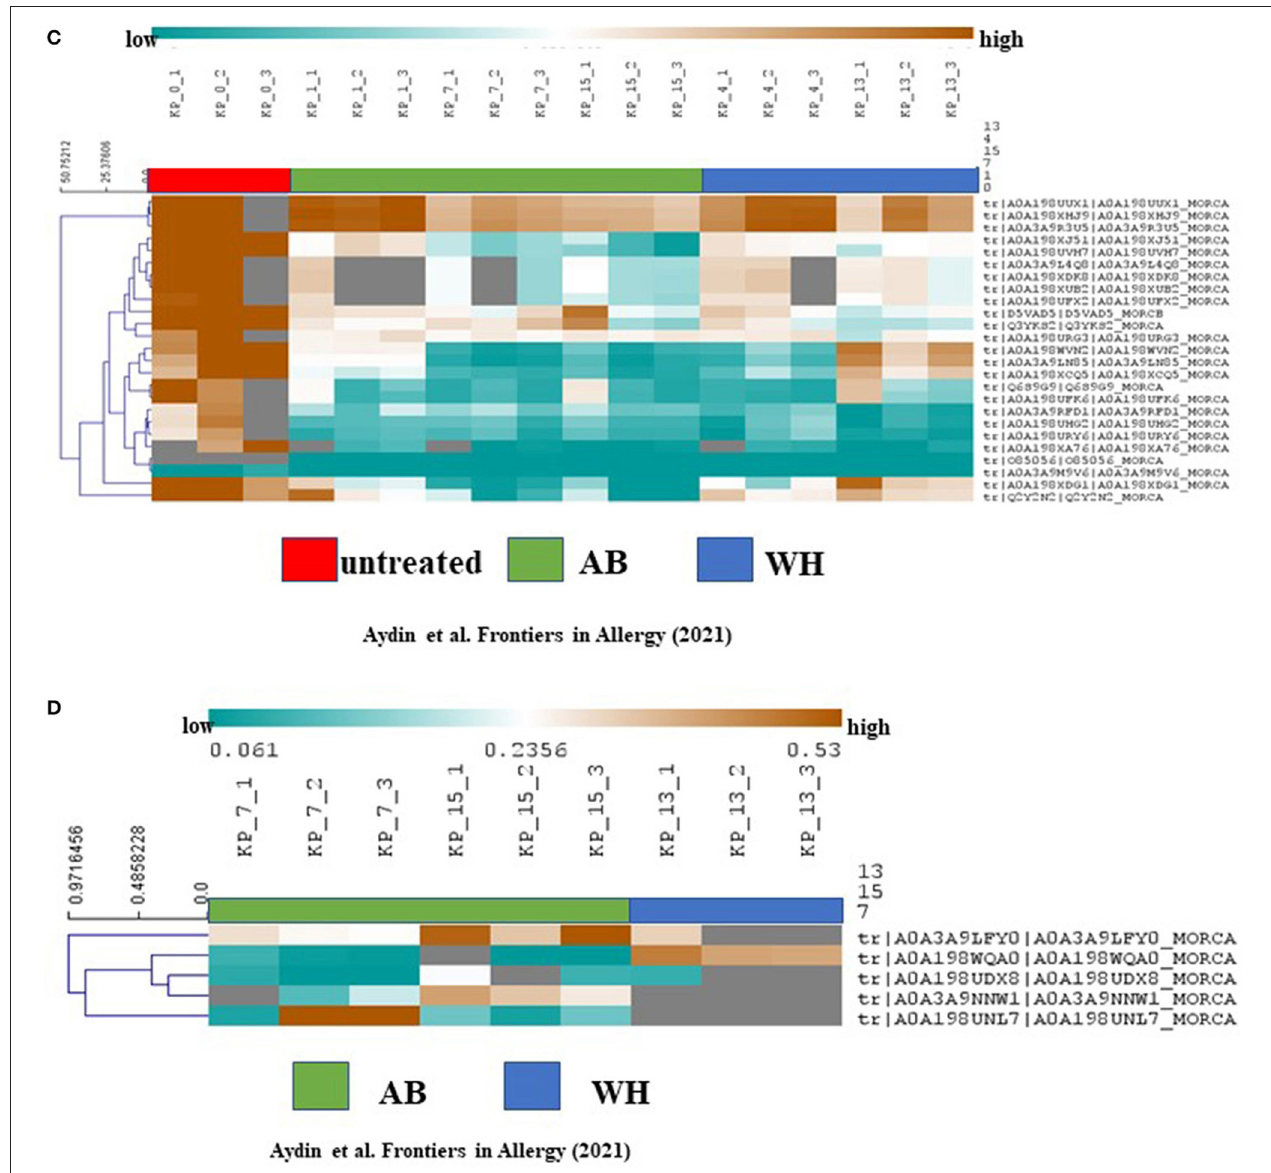
FIGURE 4 | Proteome analyses revealed cohort-specific differences and TtcA was associated with WH. (A) Proteome analyses of the cultures showed the following quantified proteins (left: human and M. catarrhalis ; right: M. catarrhalis ) highlighted in a Venn diagram, depicted in unteated (UT) (red), AB (green) and WH (blue). The size of the circular area is proportional to the number of quantified proteins in each group. Healthy controls had less protein differences compared to WH and AB. A distinct proportion in the AB group had cohort-specific proteome abundance levels. (B) Proteome analyses of the cultures including human and M. catarrhalis -associated proteins presented significant abundance levels in AB, WH, and UT groups. The abundance levels are colored ranging from blue (low abundance) to orange (high abundance). Gray color represents missing information for each protein in the group. Interestingly, AB, WH, and UT had common high abundance levels for ALBU_Human, K1C19_Human, A0A198UUX1_MORCA, A0A198XHJ9_MORCA, A0A349RU5_MORC, and TRFE_Human. WH-specific high abundance levels were furthermore observed for different M. catarrhalis specific protein levels and this level was found to be reduced in AB, except for D5VAD5_MORCA and Q3YKS2_MORCA. (C) Spearman rank correlation was performed for clustering samples. A separate analysis for solely M. catarrhalis -specific proteins revealed significant correlations between AB, WH, and UT, and in toto n = 25 proteins did cluster with each group. The abundance levels range from blue (low abundance) to orange (high abundance). In detail, AB and WH had different abundances in few protein levels. (D) A differentiated analysis for the WH group presented a group-specific abundance protein level in comparison to the AB group; in particular, tRNA-cytidine-2-sulfurtransferase (TtcA), tr|A0A198WQA0|A0A198WQA0_MORCA, was highly significantly abundant only in the WH group (AB, Asthmatics; WH, Wheezers; HC, Healthy controls).